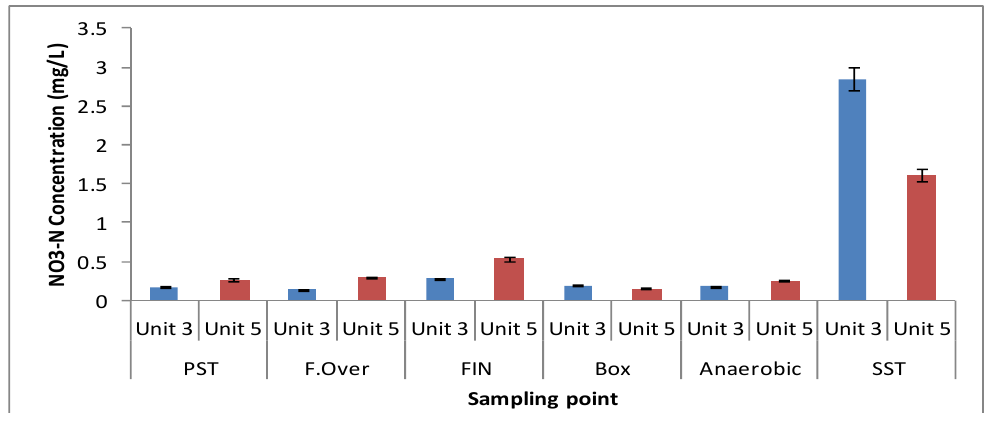
Figure 4. Nitrate concentration in wastewater samples collected from different zones of both Unit-3 and Unit-5 of the Northern Wastewater Treatment Works.